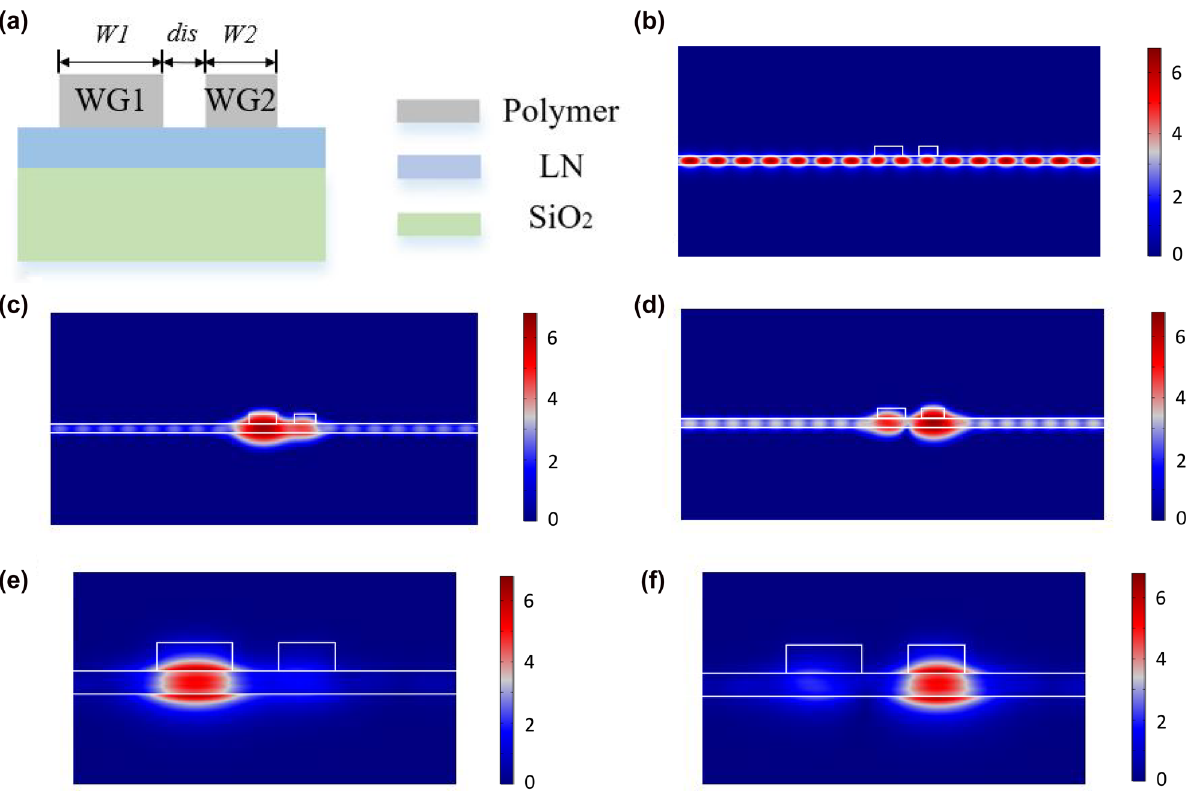
Figure 1: Coupled polymer strip waveguides based dual-BIC scheme. (a) Cross section of the structure. Normalized electric field distribution of (b) the TE continuous mode, (c) and (d) the TM leaky modes, and (e) and (f) the TM bound modes in the dual-BIC scheme. The TE eigenmode has dominant TE continuum mode that locates in the LN layer, and the TM one is mainly located under the polymer strip.